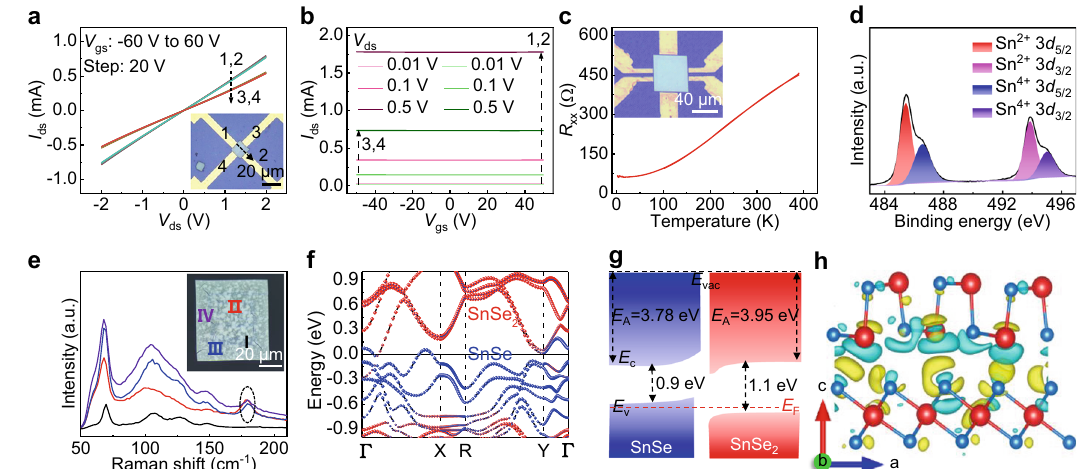
Fig. 3 | Metallic behavior of PVD-synthesized 2D p-doped SnSe. a Output char- acteristic curves of SnSe, collected both along 1 – 2 and 3 – 4 directions. Inset is the corresponding OM image of a back-gate device. b Transfer characteristic curves of the SnSe back-gate device. c Temperature-dependent longitudinal resistance of SnSe(with the thickness of~46nm). Inset is the corresponding OMimageof a Hall bardevice. d XPSspectrumoftransferred2Dp-dopedSnSenanosheetsonSiO 2 /Si, showing the coexistence of Sn 2+ and Sn 4+ . e Raman spectra captured from four